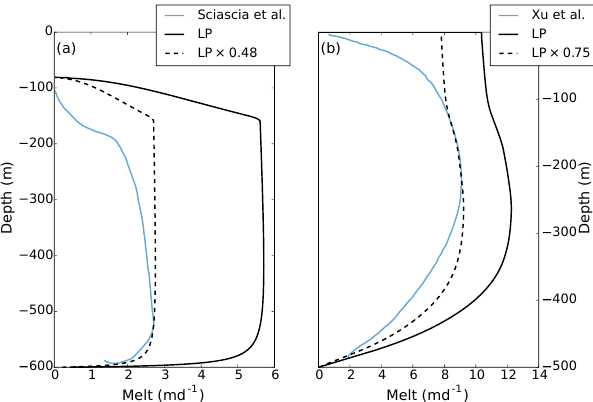
Figure 11. Comparison between LP, CP and GCM simulations. (a) Experimental results from Xu et al. (2012) (blue line) and LP = 30m 2 s − 1 and E 0 = model (black, solid line) for Q sg = 150 5 0 . 07, U 0 = 3ms − 1 and the same stratification as in Xu et al. (2012). A scaling factor of 0.74 is needed to match the two melt profiles (black, dashed line). (b) Average melt rate over a 150m wide and 500m deep glacier part as a function of discharge localized in one channel. Following Xu et al. (2013), for the x axis, the discharge Q sg was divided by the area of the ice face A ice = 150 × 500m 2 so that q sg = 50mday − 1 corresponds to Q sg = 43 . 4m 3 s − 1 . The nu- merical results of Xu et al. (2013) are displayed with the blue line. Taking the same conditions ( T a S a , Q sg ) and an entrainment factor of E 0 = 0 . 1 the CP model gives the solid black line. To match the experiment a scaling factor of 3.40 is needed (black, dashed